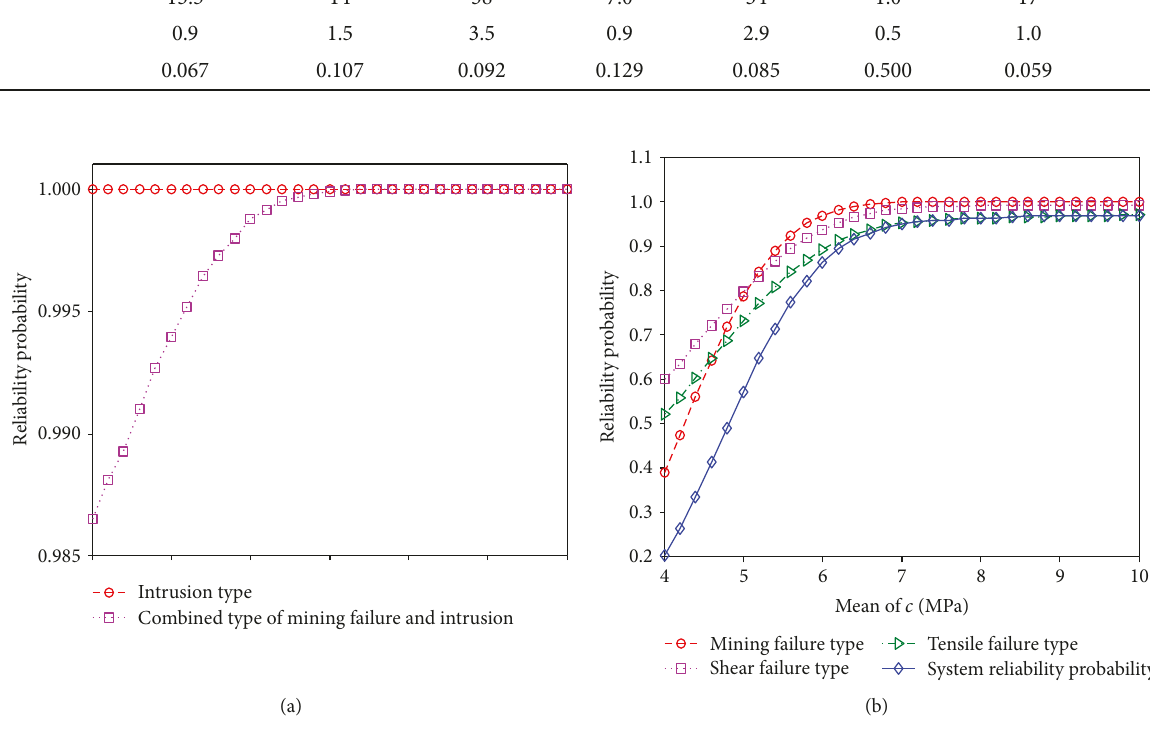
Figure 5: Relationship between the mean value of c and the reliability probability. (a) Failure modes of intrusion type and the combined type of mining failure and intrusion and (b) mode diagram of mining failure, 585 shear and tensile failure in key strata, and system failure.